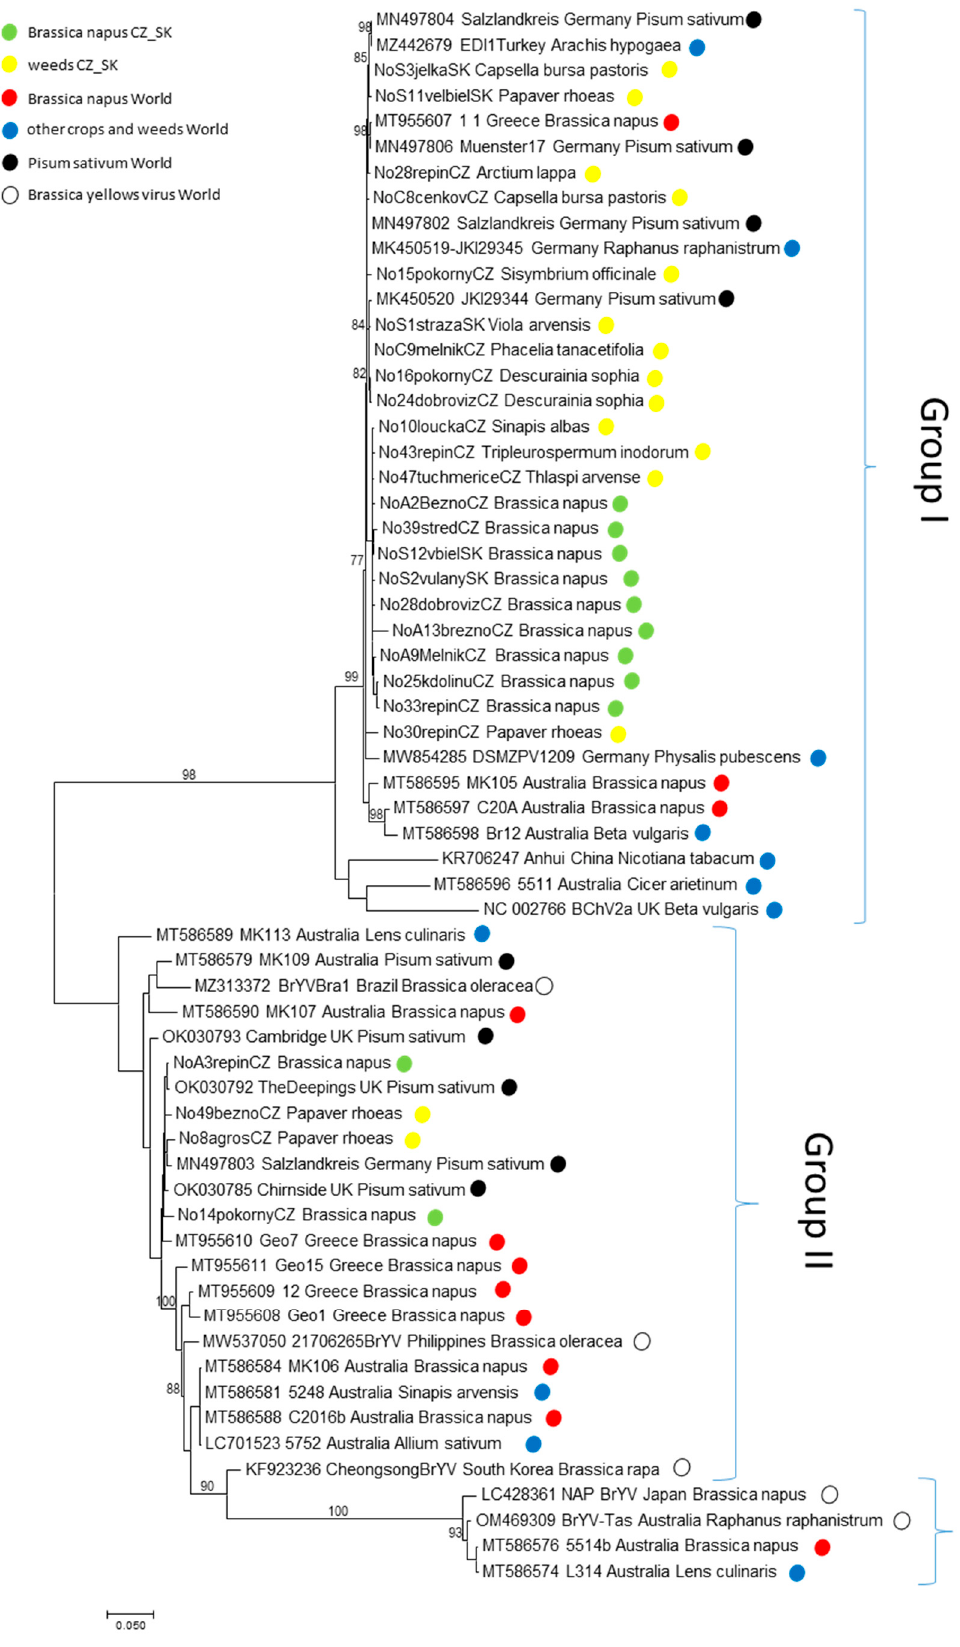
Figure 5. Maximum likelihood phylogenetic tree constructed from alignments of partial TuYV